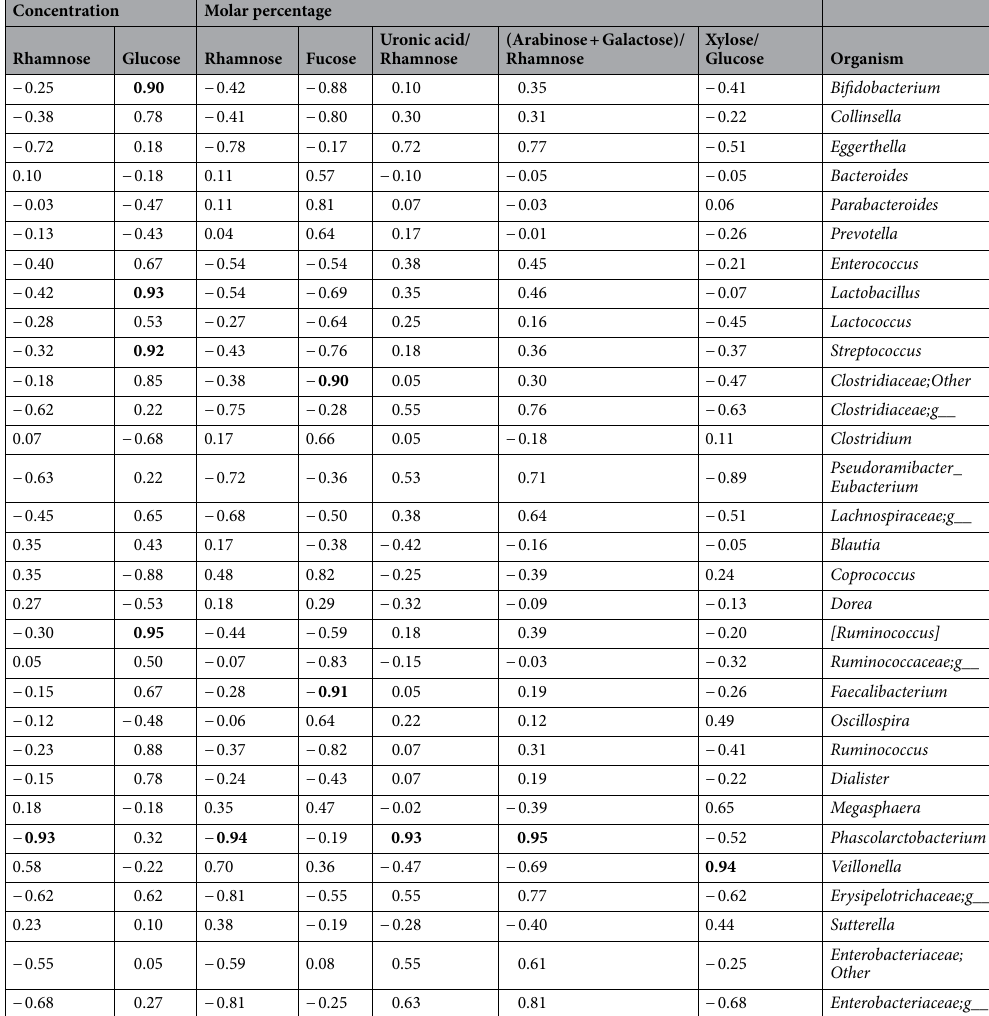
Table 4. Spearman correlations between fibre-derived sugar composition of the foods and the changes in bacterial taxa at the end of 10 h of fermentation. Only sugars with at least one correlation ( r ≥ ± 0.9 shown in bold, FDR-adjusted P < 0.1, multiple hypothesis testing) are